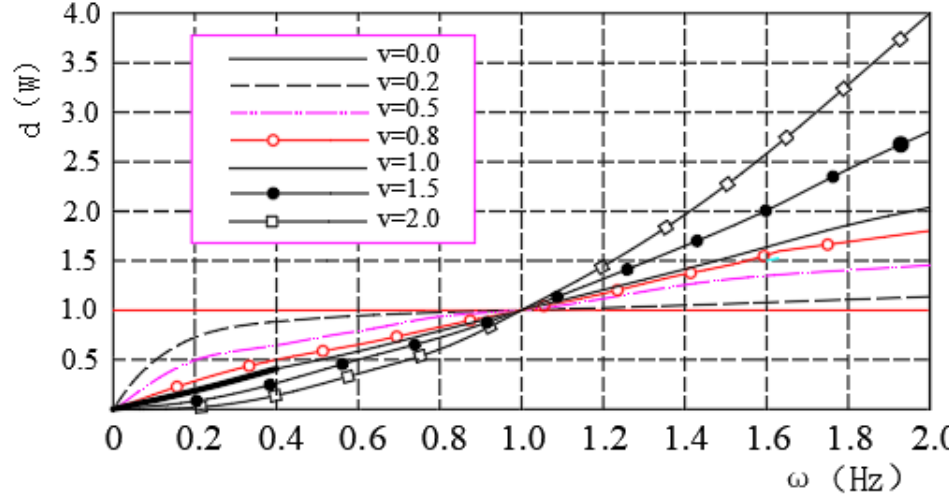
Figure 1. Amplitude-frequency characteristic curve of fractional-order differential operator.